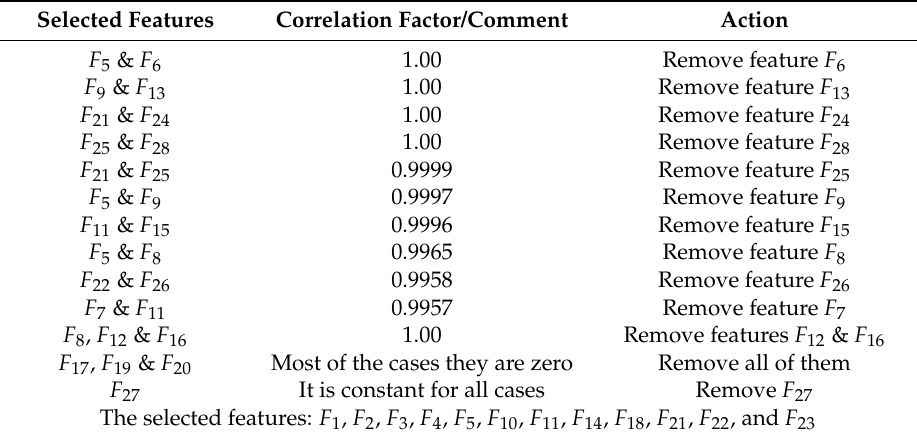
Table 1. ST Extracted Feature Selection and Removal Process